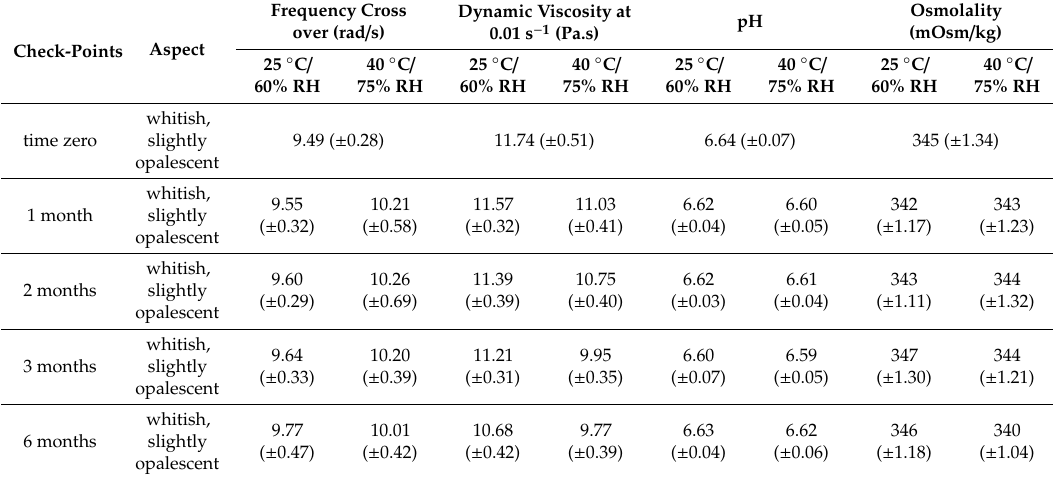
Table 7. Aspect and functional parameters of the optimized HA formulation with PC subjected to stability study in ICH long-term and accelerated conditions (mean values ± s.d.; n =